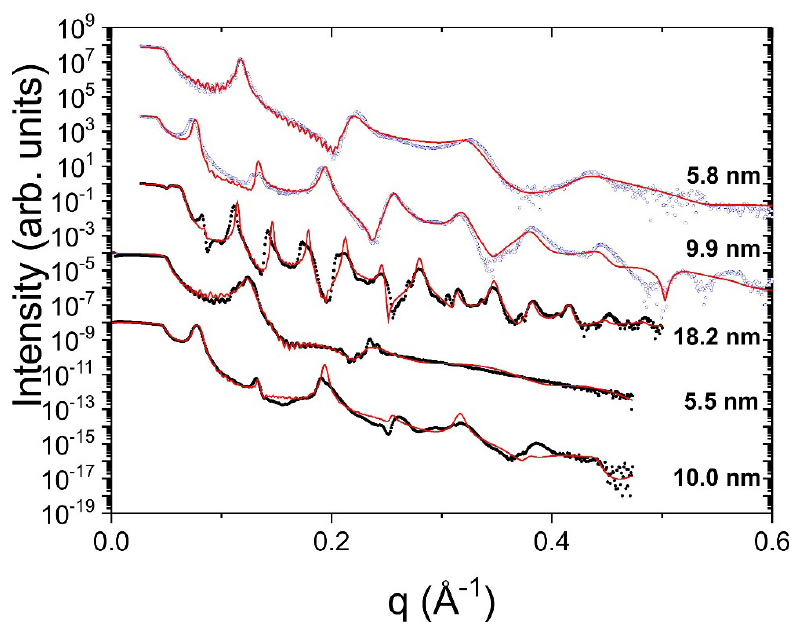
Figure 1. X-ray reflectivity measurements for the MoSi/Si (black dots) and Mo 0.85 Si 0.15 /Si (blue circles) multilayers. The period is indicated. The corresponding simulated XRR curves are shown as red